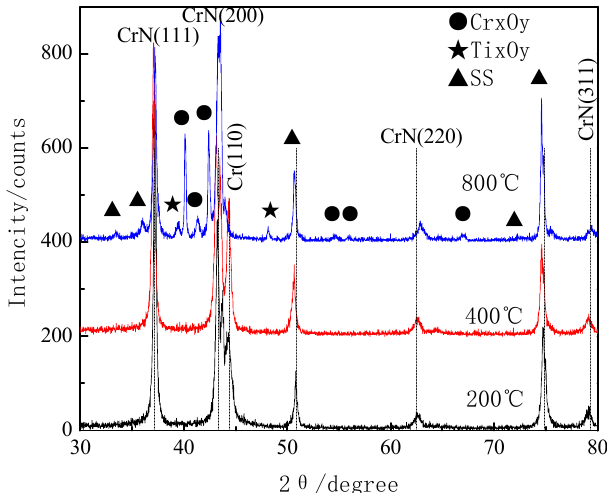
Figure 11. Friction curves of CrN film and Cr 38.7 Ti 3.7 B 6.4 N 51.2 composite film tested at 200 °C.